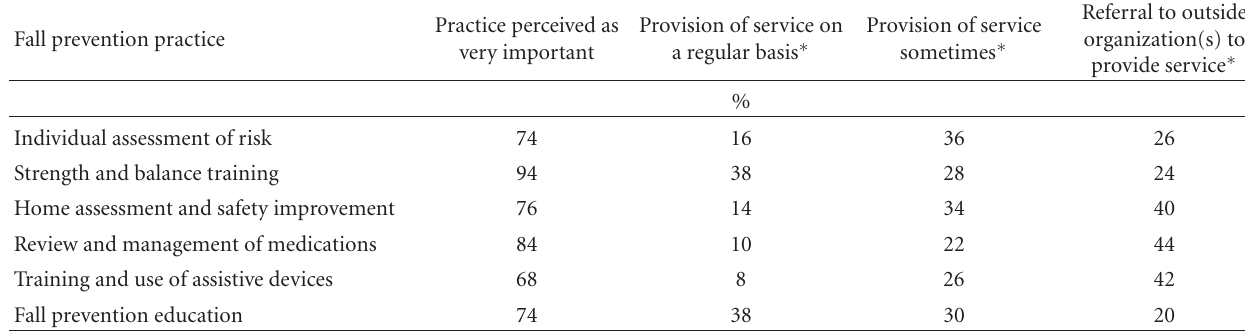
Table 2: Attitudes and provision of fall prevention services among community-based, senior-serving organizations, n =